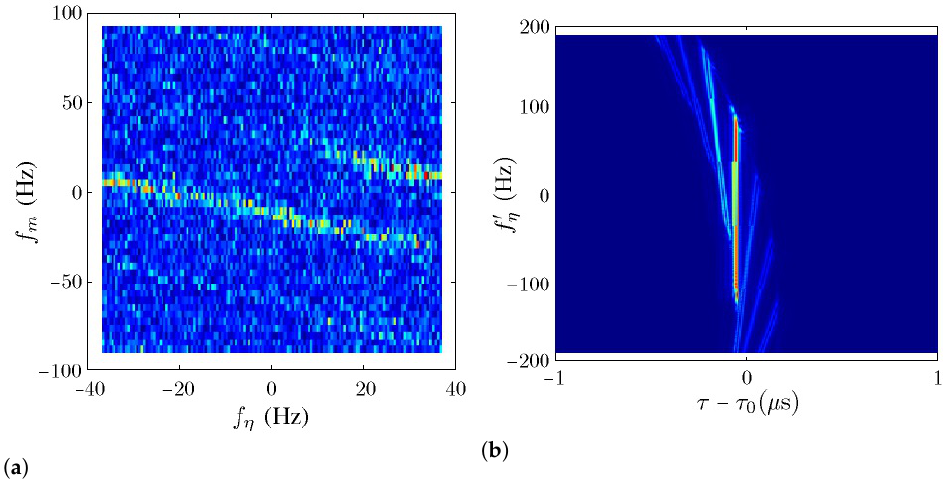
Figure 23. Acquired images of a point target with parameters listed in Table 6, ( a ) proposed method,